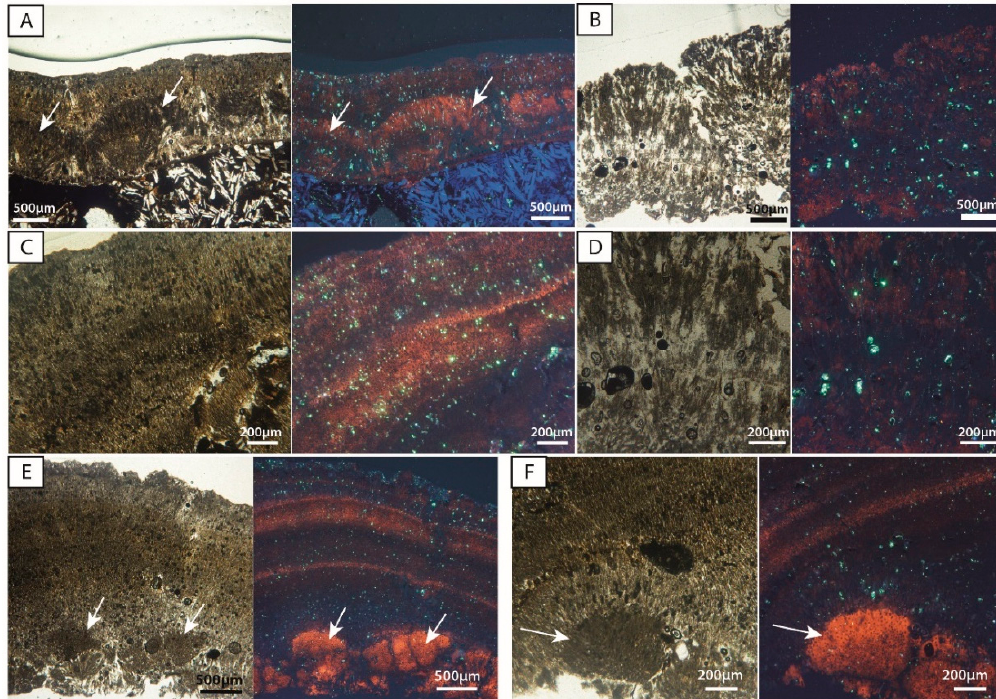
Figure 3. Photomicrographs showing paired thin sections under plane polarized light and associated cathodoluminescence. ( A ) Dense crust on basalt substrate. Fan-like shapes (arrows) stand out under cathodoluminescence. ( B ) Porous crust. ( C ) At higher magnification of the dense crust, laminae are visible under cathodoluminescence. ( D ) At higher magnification of the porous crust, slight changes in luminescence under cathodoluminescence are observed. ( E ) The dense crust showing that clear laminated structures of different luminescence are visible under cathodoluminescence. White arrows show highly luminescent concretions. ( F ) Higher magnification of the rounded structure shown in ( E ), indicated by white arrows. The rounded structure is more luminescent than the surrounding matrix.